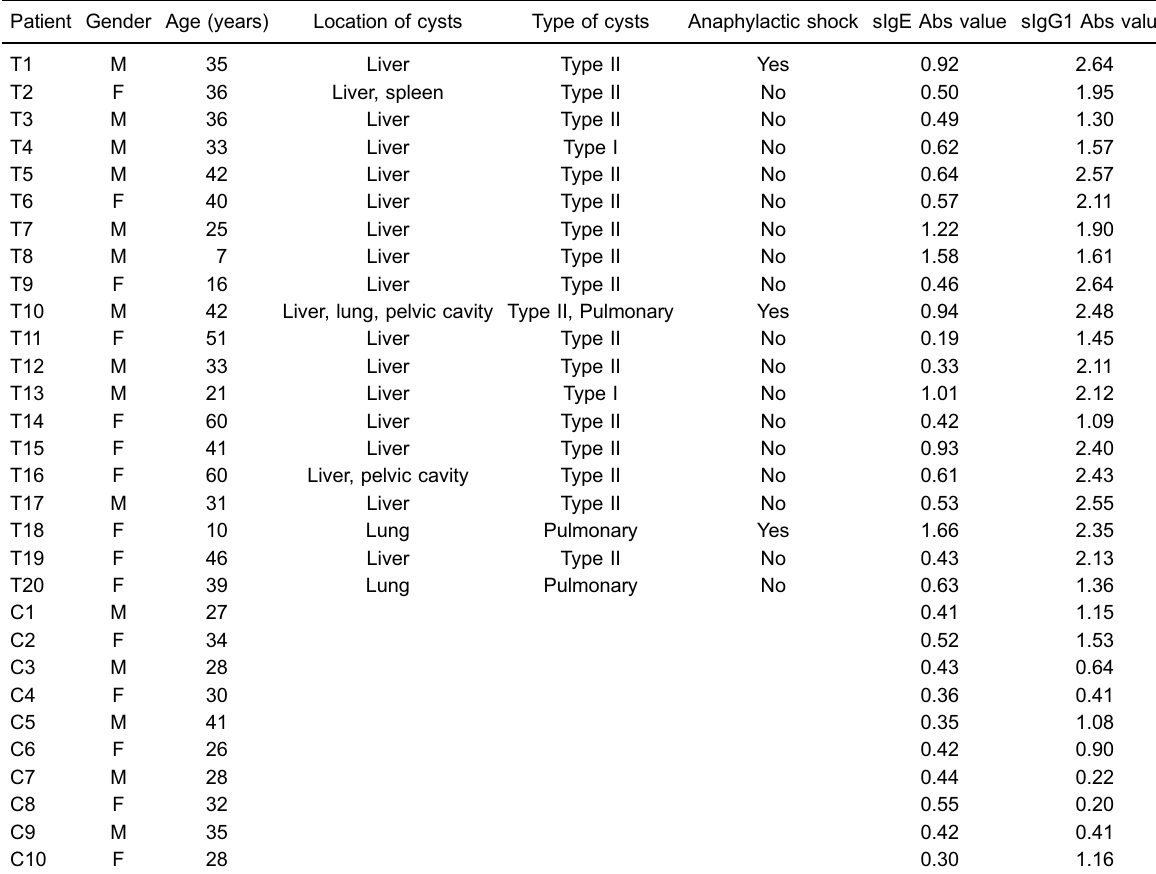
Table 1. Demographic, clinical, and antibody characteristics of patients and disease